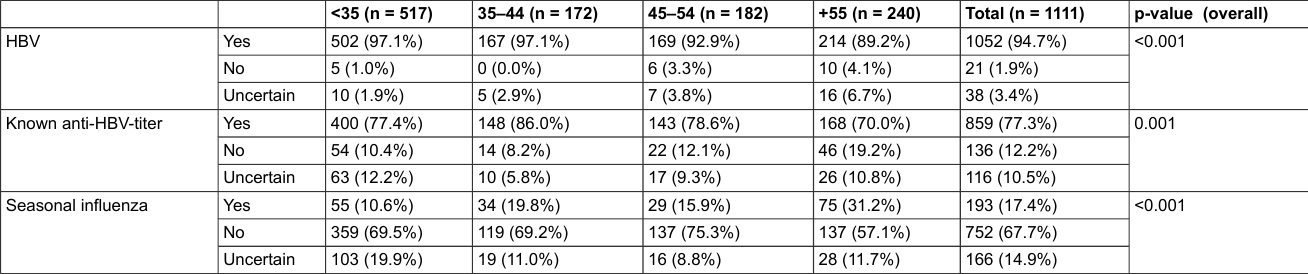
Table 6: Age-related immunisation status, by vaccination or by immunity against influenza, HBV and known anti-HBV titre for the different age categories. <35 (n =